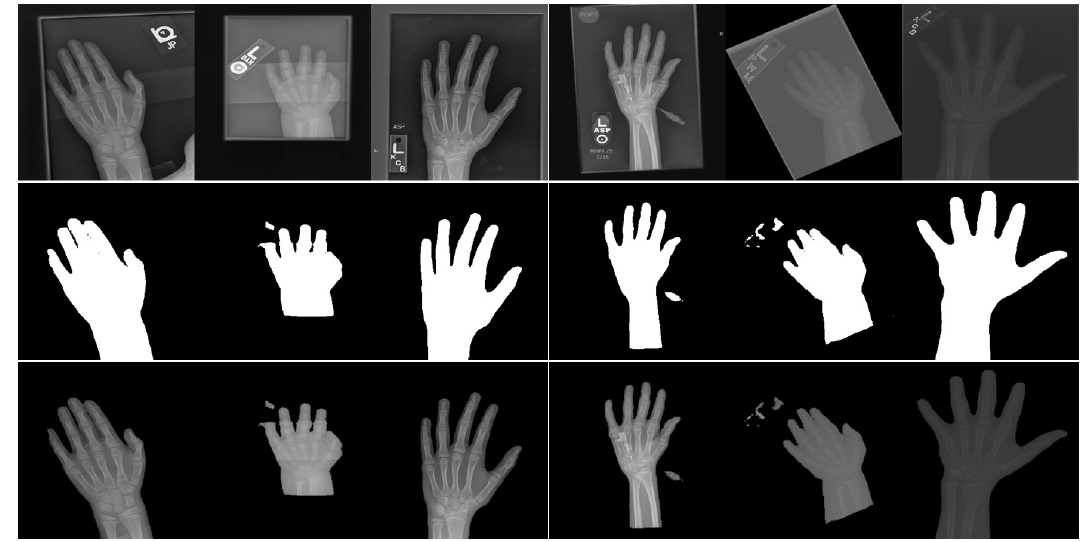
Figure 4. Segmented hand region while using DeepLab V3 plus; the first-row samples depict the original input images, the second-row samples depict the segmented mask, and the third-row samples depict the masked hand